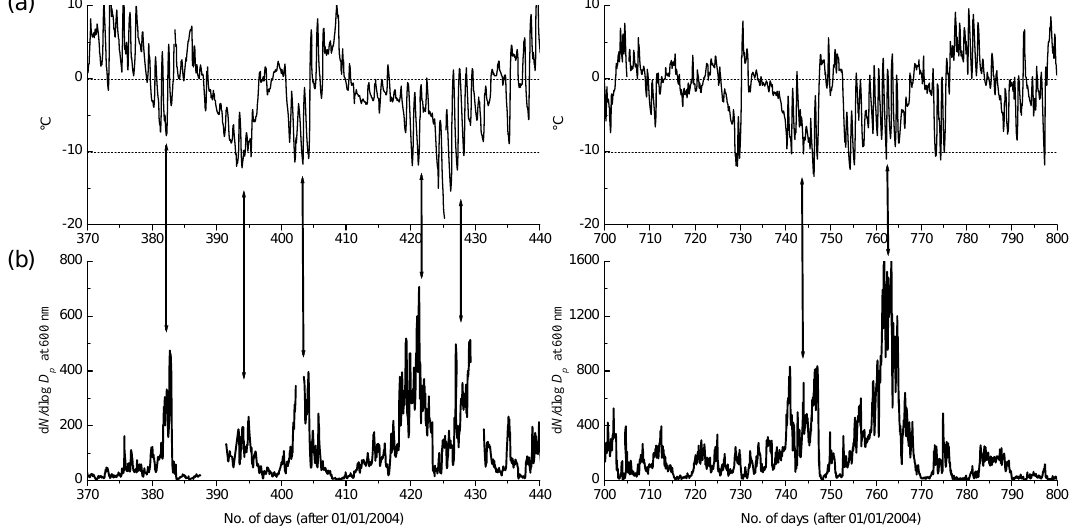
Fig. A1. Time history of ambient temperature (a) and the number concentration of 600nm-particles. The left-hand and right-hand graphs correspond to the winters 2004/2005 and 2005/2006, respectively. Several episodes that show simultaneous high particle concentrations and low temperatures are marked by